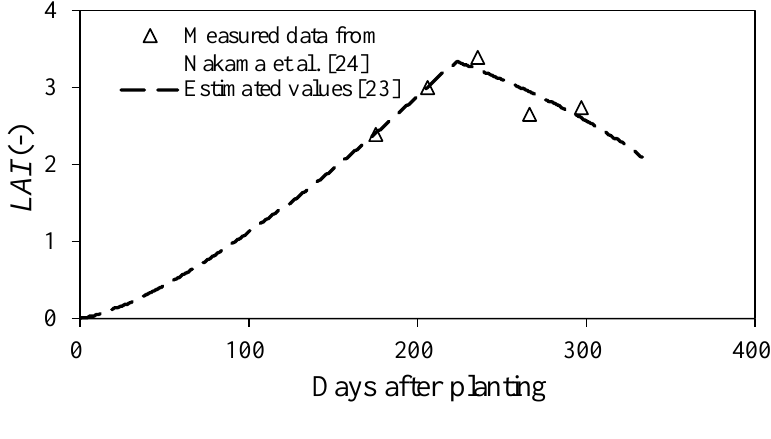
Figure 2. Change of LAI after planting of sugarcane.